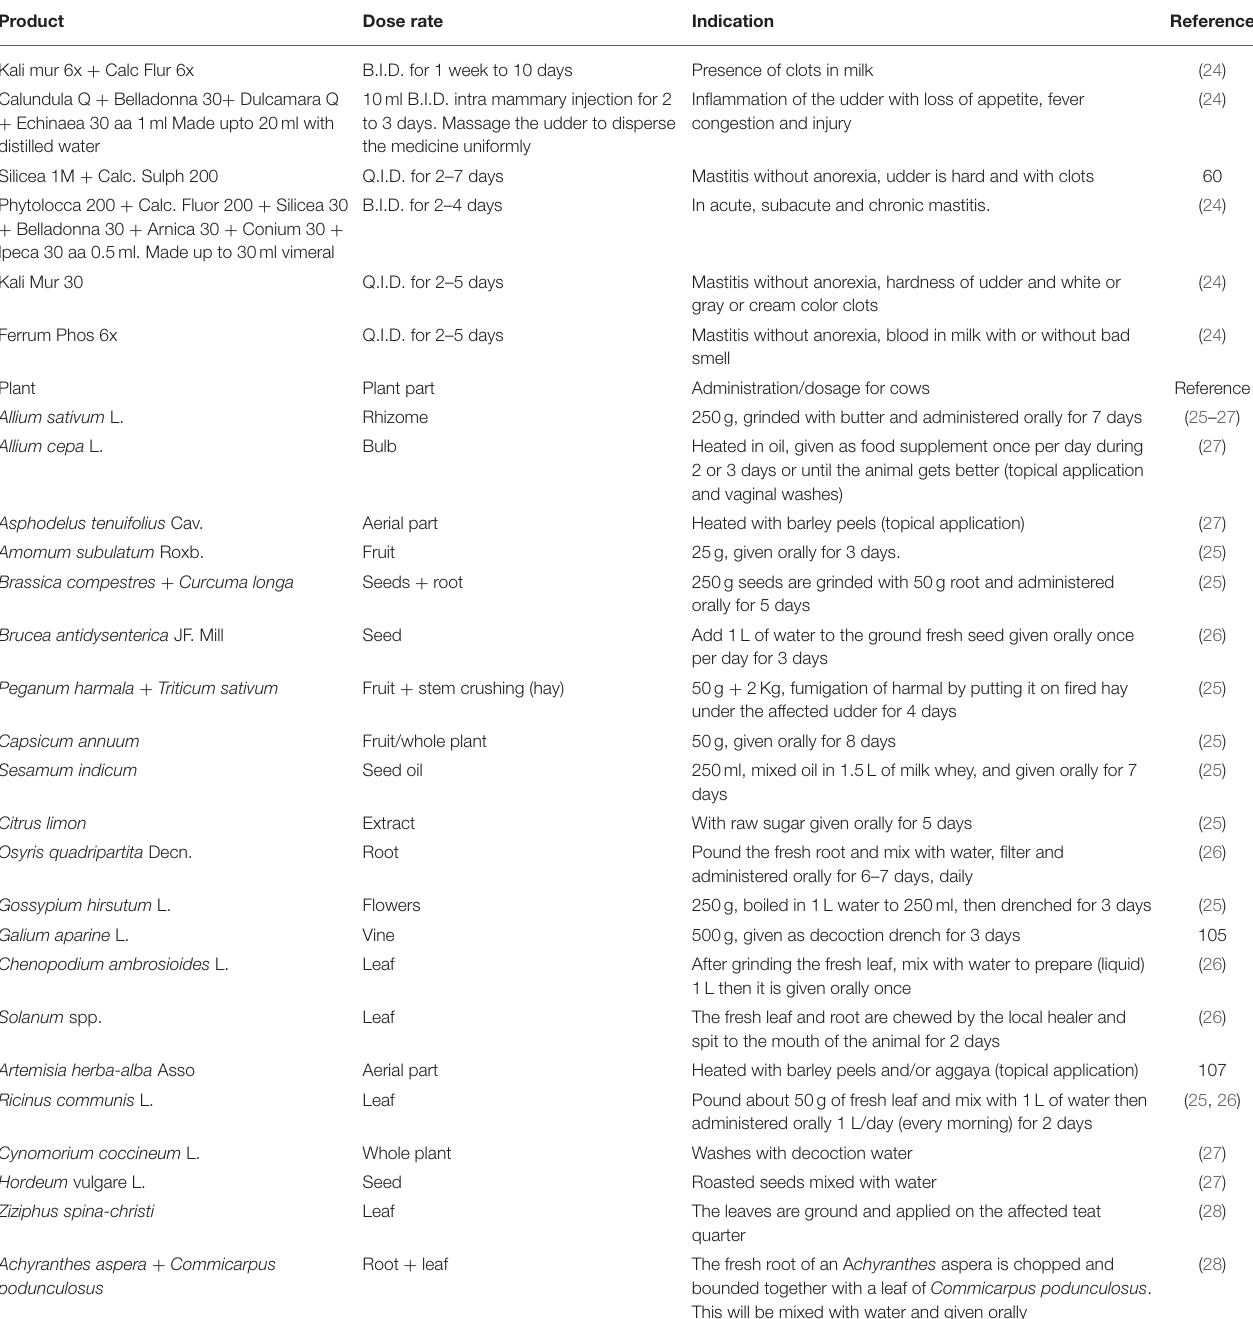
TABLE 3 | Ethno-veterinary medicinal products, preparation and administration for the treatment and control of